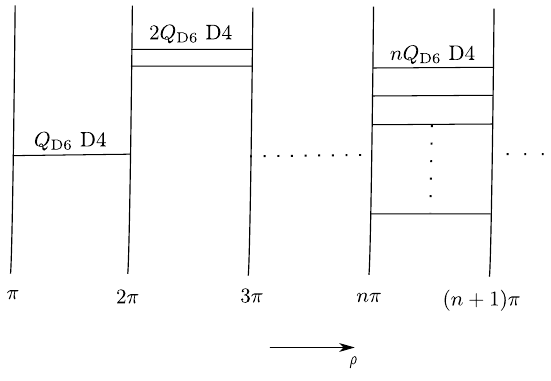
Figure 1 . Brane set-up associated to the 4d background theory. NS5-branes are located at ρ n = nπ and nQ D4-branes are stretched between them in each [ ρ D 6